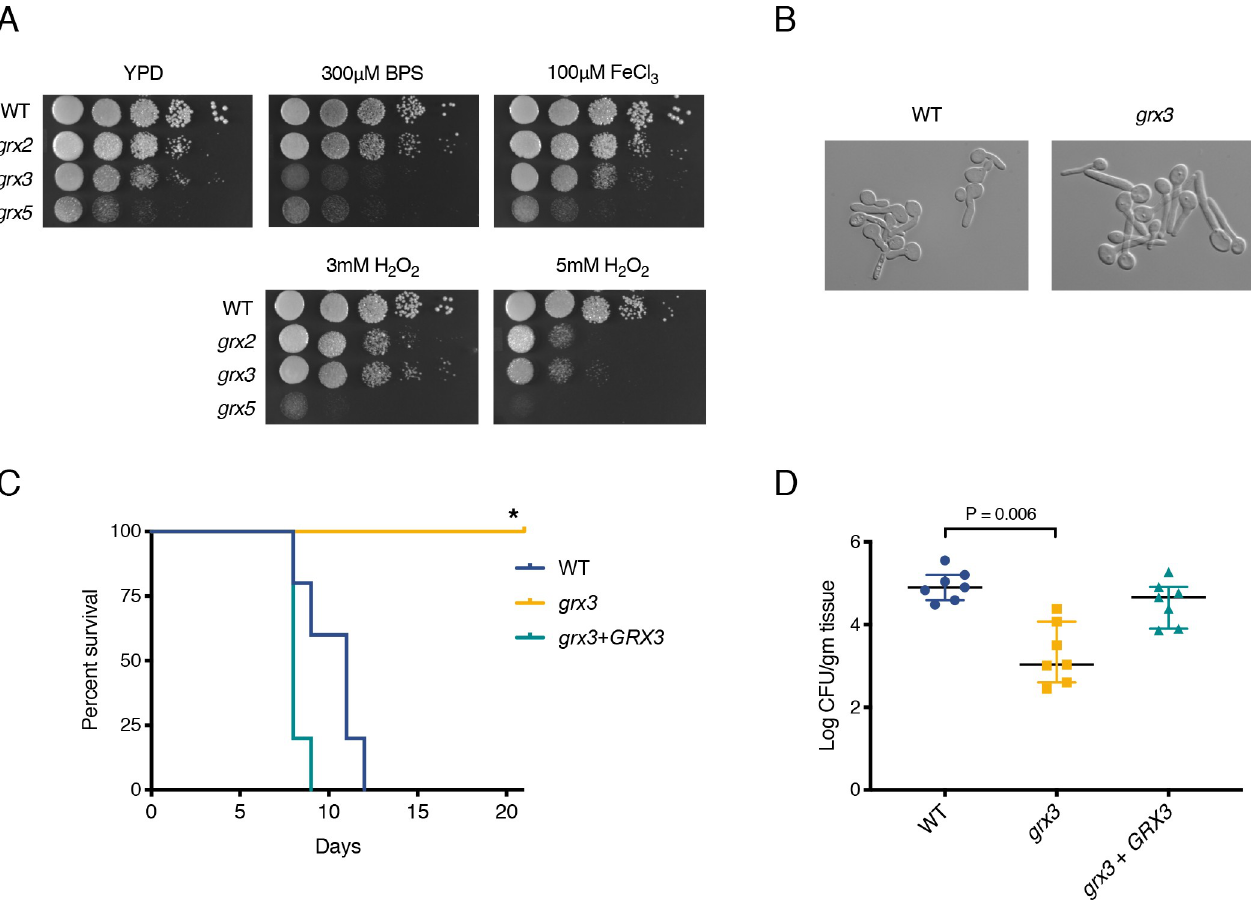
Fig 1. Grx3 is required for low iron stress and C . albicans pathogenicity in murine models of infection. A. Growth of glutaredoxin mutants under oxidative and iron stresses. Wild-type (WT) (HLY4494), grx2 (HLY4491), grx3 (HLY4492), and grx5 (HLY4493) were spotted with 10-fold serial dilutions onto YPD plates containing 300 μ M BPS, 100 μ M FeCl 3 , 3mM H 2 O 2 , or 5mM H 2 O 2 and grown for 2 days at 30˚C. B. Hyphal initiation of WT and grx3 . Saturated overnight cultures of WT (HLY4494) and grx3 (HLY4492) cells were diluted 1:100 into fresh, pre-warmed YPD and grown for 1hr at 37˚C and imaged. C. Survival of mice infected intravenously with the indicated strains. 5 mice per strain were injected in the lateral tail vein with WT (HLY4568), grx3 (HLY4565), or grx3 cells complemented with pTDH3-GRX3 (HLY4566). � p = 0.0021 compared to WT by the log-rank test. D. Oral fungal burden of mice infected with indicated strains. 7 Mice per strain were infected orally with WT (HLY4568), grx3 (HLY4565), or grx3 + pTDH3-GRX3 (HLY4566) cells. The median values and interquartile ranges are plotted as horizontal bars. Statistical significance was determined by the Wilcoxon rank sum test.